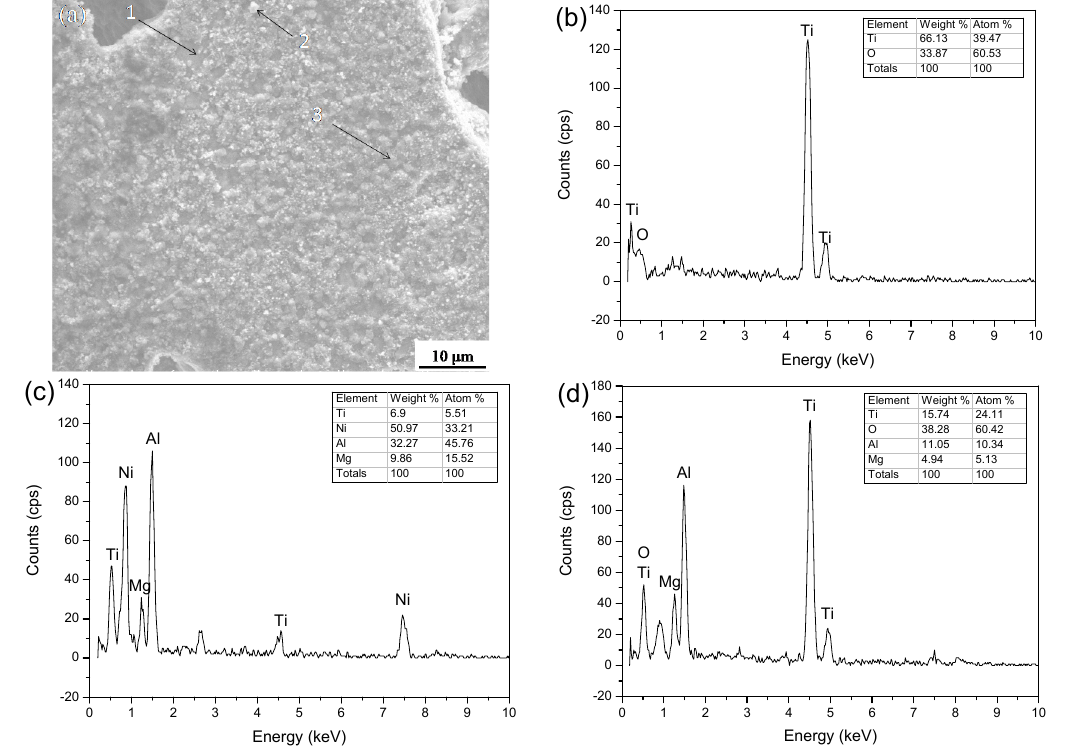
Figure 9. ( a ) SEM result of the coating surface after immersion test; and ( b – d ) EDS results of the corresponding to labeled regions, including 1, 2, and 3 in ( a ), respectively.